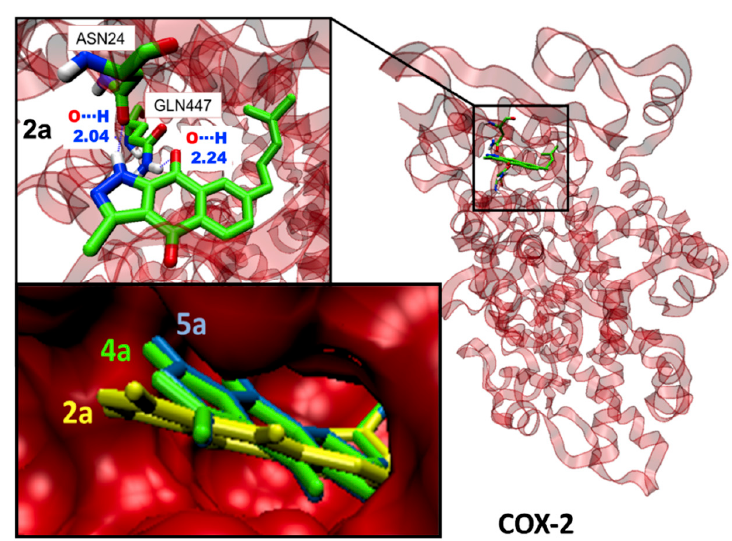
Figure 3. Visualization of the potential binding site and docking poses of BIZQs 2a , 4a , and 5a into COX-2.